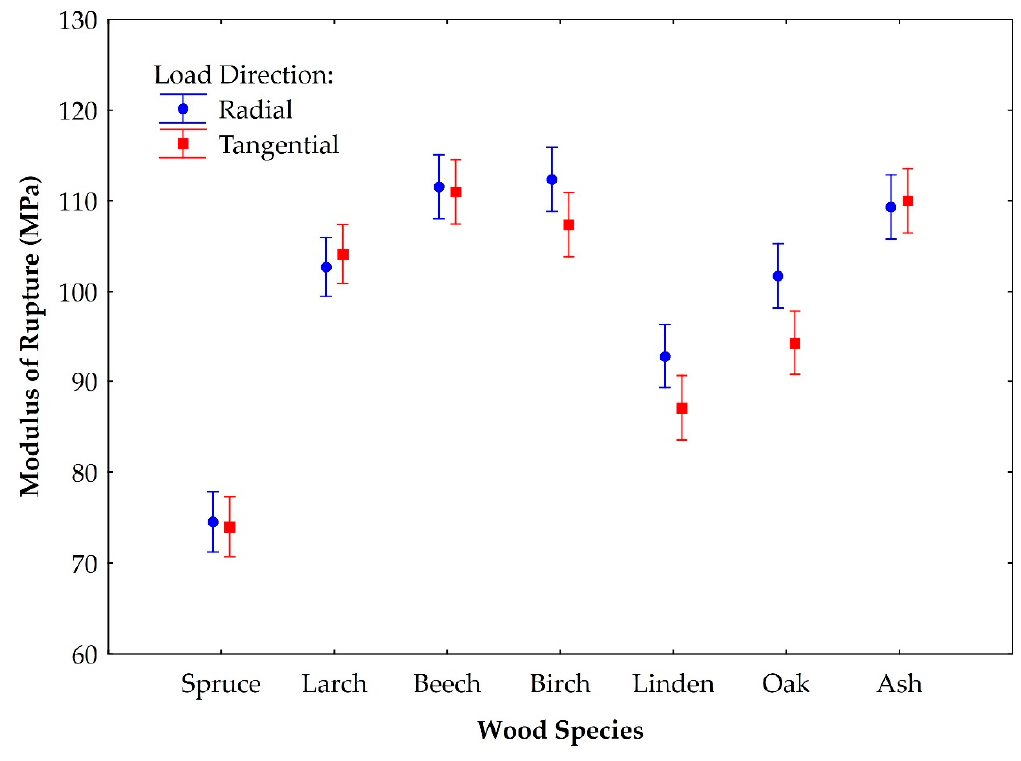
Figure 7. Graphic visualization of the effect of load direction on modulus of rupture (bending strength) for specific wood species.